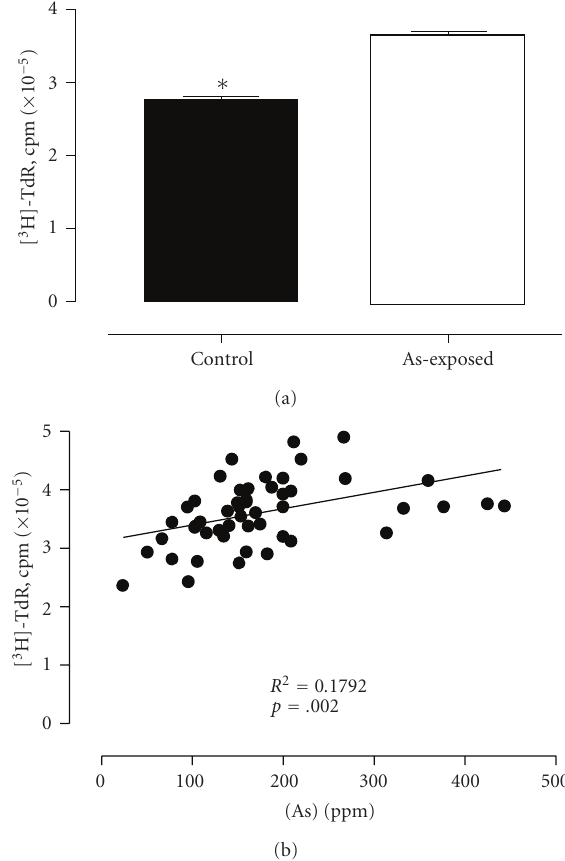
Figure 1: Comparative e ff ect of arsenic exposure on the prolif- eration of lymphocytes isolated from low- and high-As-exposure human populations. Correlation of lymphocyte proliferation and urinary excretion of As from highly As-exposed population. (a) Proliferation was assessed by comparison of 3 H-Thymidine incor- poration ([ 3 H]-TdR, cpm) in lymphocytes isolated from the low- As-exposure group (control group, n = 31) and from the high-As- exposure group ( n = 50). Statistically significant di ff erences were found between the two groups (U-Mann-Whitney test P = . 0138). (b) Relationship between 3 H-Thymidine incorporation and arsenic concentration in urine (ppm) of the highly exposed population ( n = 50). Association between the two variables was determined by R -Pearson ( P = .